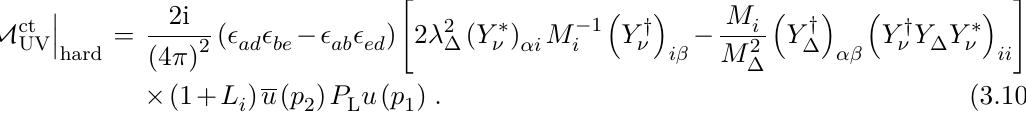
Figure 2 . The 1LPI diagrams with external lines generated by the in the type-(I+II) seesaw